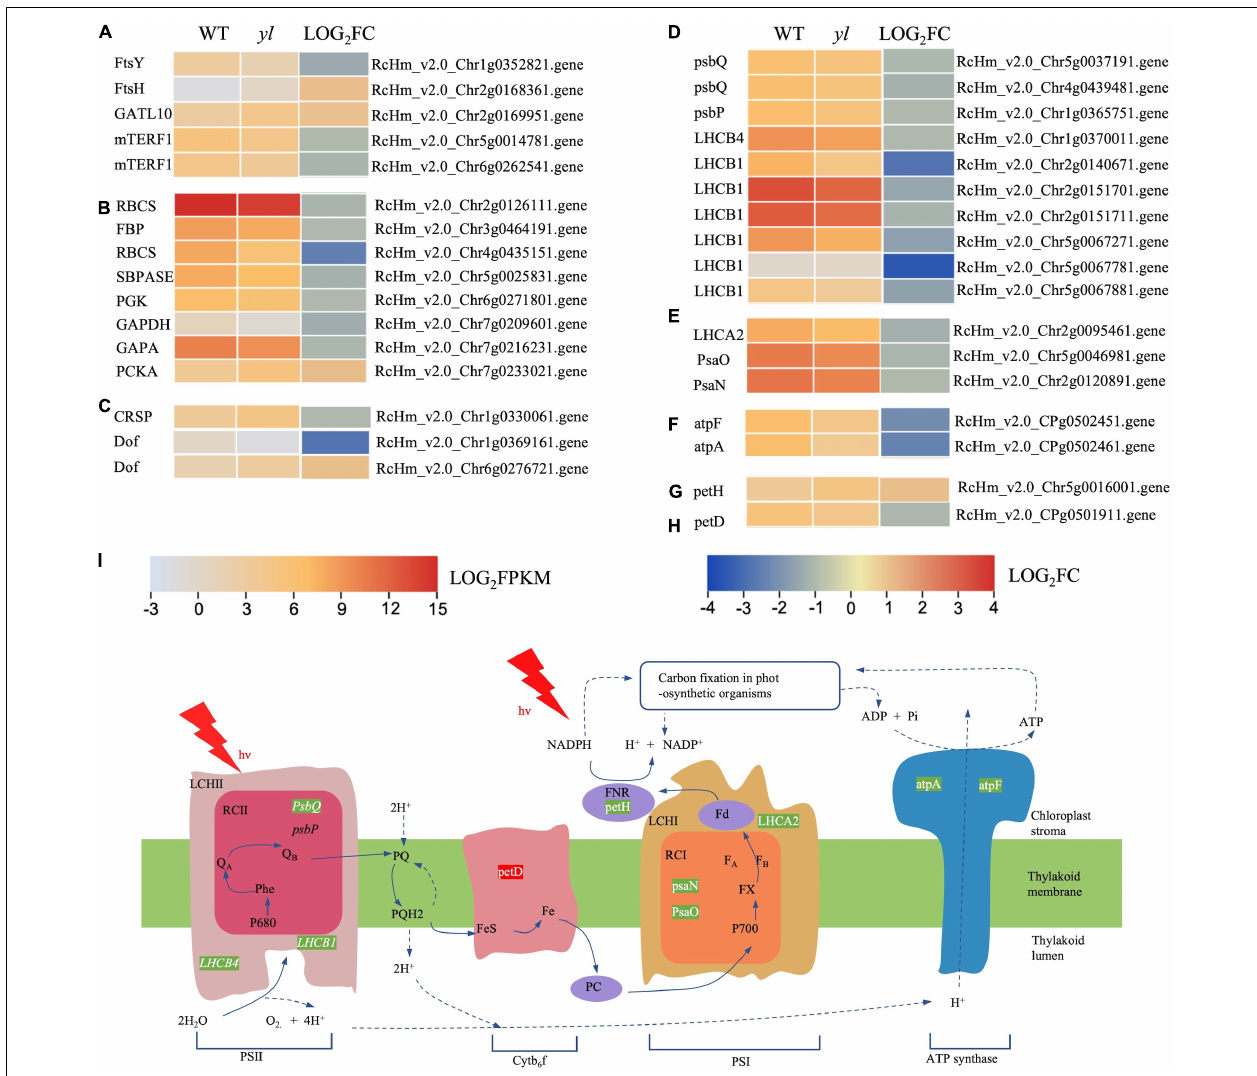
FIGURE 5 | The expression profiles of DEGs involved in chloroplast development and function. (A) DEGs involved in chloroplast division and development. (B) Expression profiles of DEGs involved in carbon fixation in photosynthetic organism photosynthesis metabolism. (C) DEGs involved in stomatal formation and development. (D) DEGs involved in inorganic ion transport and metabolism. (E) DEGs involved in Cytb 6 f metabolism. (F) DEGs involved in photosystem II (PSII). (G) DEGs involved in photosystem I (PSI). (H) DEGs involved in F-type ATPase metabolism. (I) Simplified scheme for the thylakoid electron transport chain. Green letters indicate that the transcription level of genes in yl was lower than WT. Red letters indicate that was higher than WT. mTERF1, mitochondrial transcription termination factors; RBCS, ribulose-bisphosphate carboxylase small chain; SBPASE, sedoheptulose-bisphosphatase; PGK, phosphoglycerate kinase; GAPA, glyceraldehyde-3-phosphate dehydrogenase (NADP+); PCKA, phosphoenolpyruvate carboxy kinase; petH, ferredoxin–NADP+ reductase; petD, cytochrome b6-f complex subunit 4; psbP, photosystem II oxygen-evolving enhancer protein 2; PsaN, photosystem I subunit PsaN; atpF, F-type H+ -transporting ATPase subunit b; atpA, F-type H+ -transporting ATPase subunit